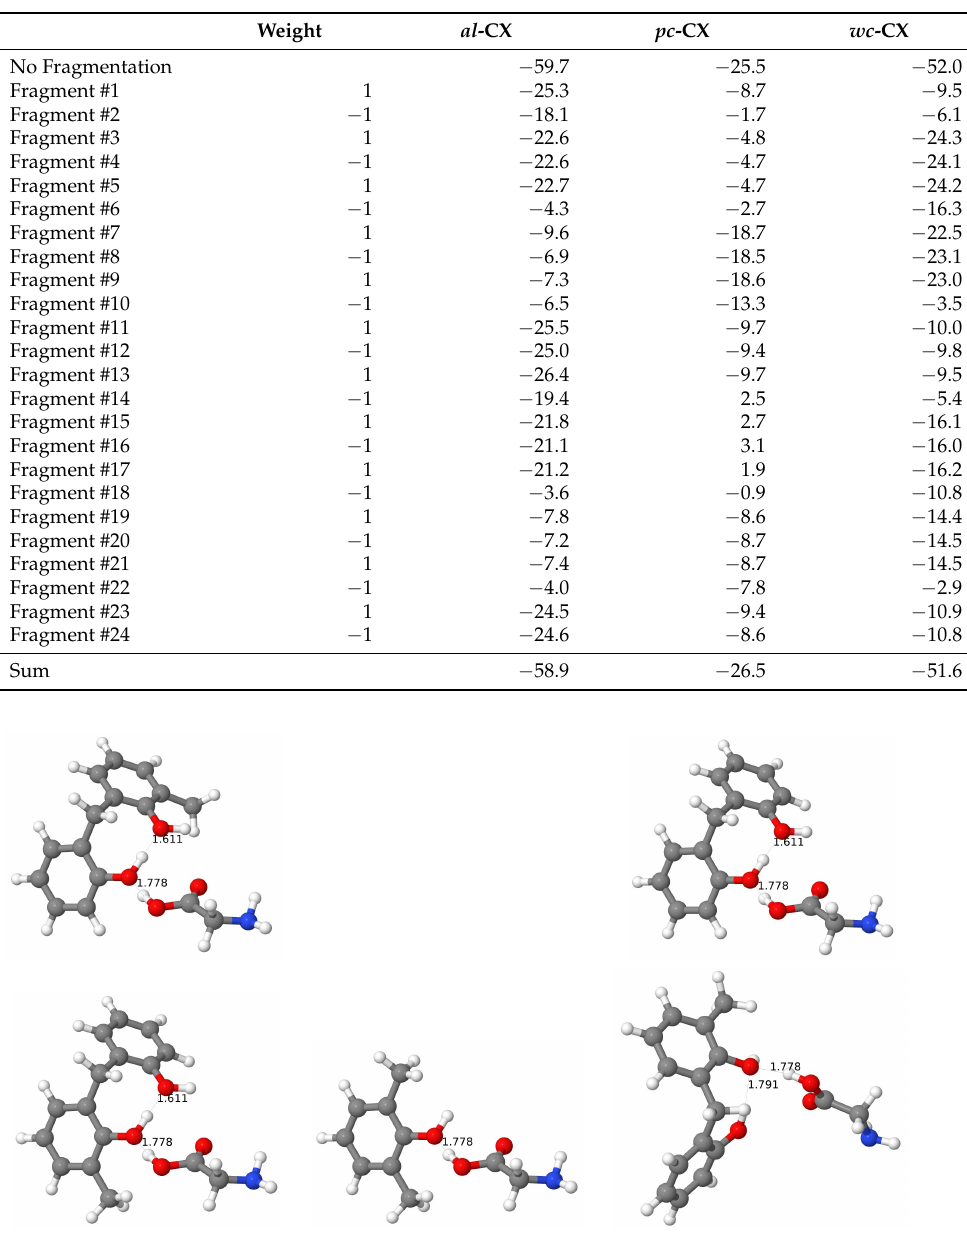
Table 4. The total SAPT0 interaction energies of unfragmented and the SSMF3 fragments for all CX conformers + Gly complex are presented. Energies are in millihartree.